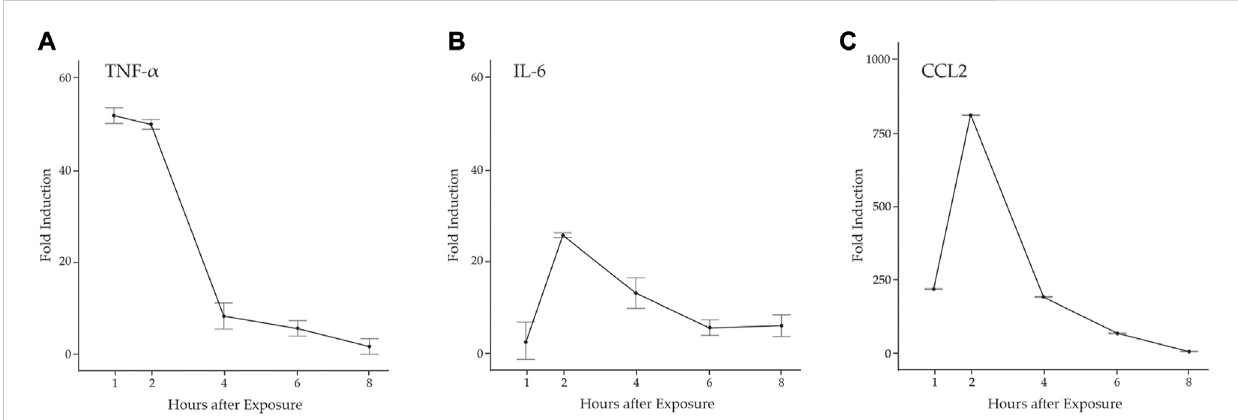
FIGURE 1 LPS induction of proin fl ammatory cytokines in primary mouse MuSCs. Transcription of (A) Tnf α (B) Il6 , and (C) Ccl2 from MuSCs treated with LPS (1 mg/mL)for1,2,4,6,and8 hwasquanti fi edbyRT-qPCR.RNAtranscriptlevelsareexpressasthefoldinductionovercontrolMuSCstreatedwithPBS.At 1, 2, and 4 h, p <